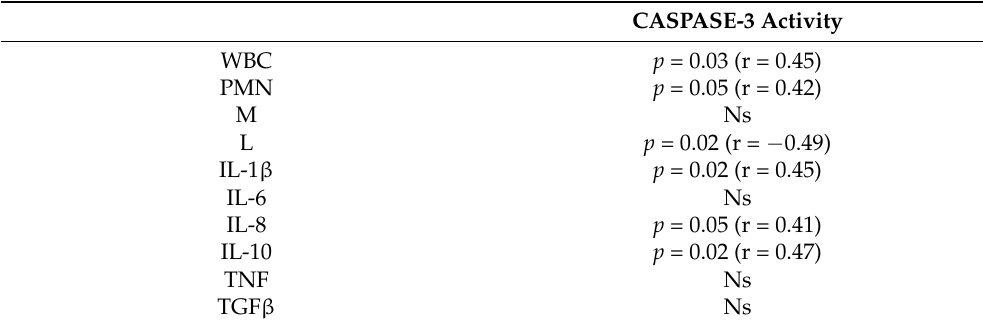
Figure 5. Caspase-3 activity determined in selected SF (n = 5). Data are shown as the median (IQR) of optical density values. p is calculated according to the Kruskal–Wallis test. Dunn’s post hoc test: * p < 0.05. Abbreviations are as follows: OA, osteoarthritis; RA, rheumatoid arthritis; PsA, psoriatic arthritis; CIA, crystal-induced arthritis. Table 6. Correlations between cellular inflammatory indices, SF cytokines, chemokine, growth factor levels, and caspase-3 activity.